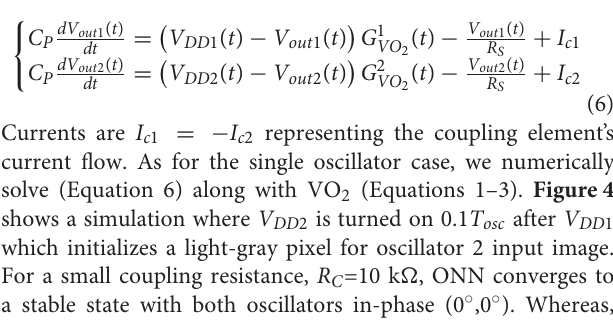
initial phase relation 1φ init = π . For t < 1 t init , the